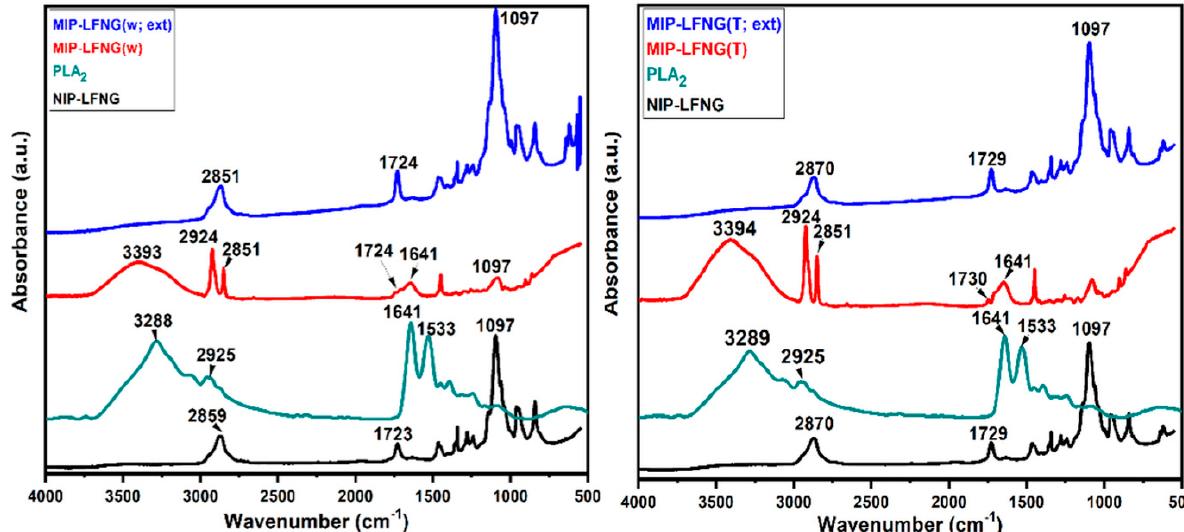
Figure 1. Fourier transform infrared (FT-IR) spectra of NIP-LFNG; PLA2 enzyme (PLA2); and MIP- LFNG (W or T) and MIP-LFNG (W, ext or T, ext) before and after PLA2 extraction, respectively.